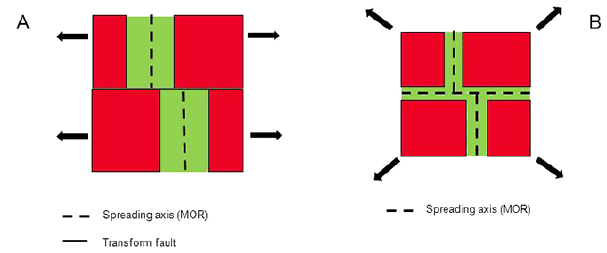
Figure 4. (A) Transform faults on a constant-size planet divide ad- jacent sections of the same oceanic plate expanding at different speeds. (B) On an expanding planet, every plate recedes from the adjacent ones, increasing the distance by moving radially. There- fore, no transform fault is needed to accommodate differential spreading rates, and a network of triple junctions and connecting spreading ridges would surround equidimensional